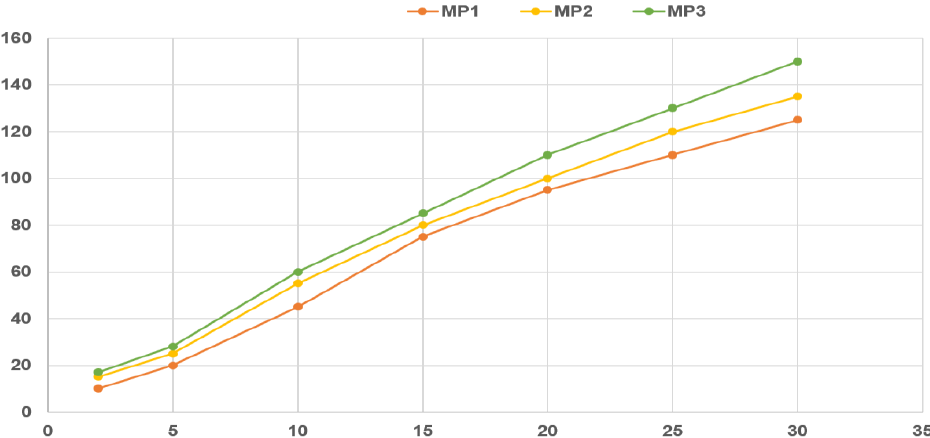
Figure 5. This figure displays the comparative battery energy consumption of the Bio-Guard app for 30 min, on the mobile phones MP1, MP2, and MP3. The X -axis represents duration, in minutes, and the Y -axis represents battery energy consumption in milliampere hours